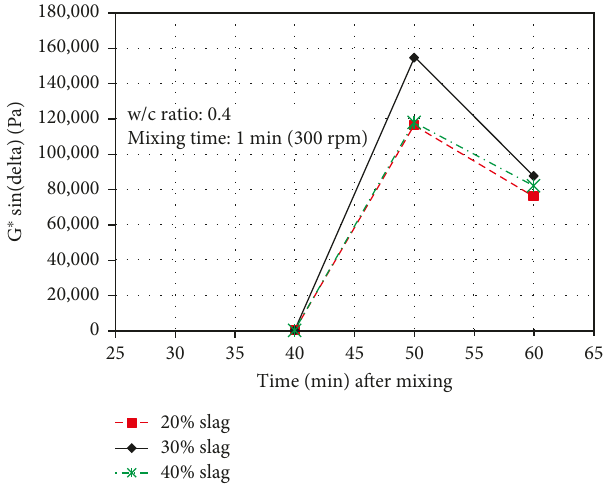
Figure 3: G sin(delta) with slag content (0.4w/c ratio). ∗